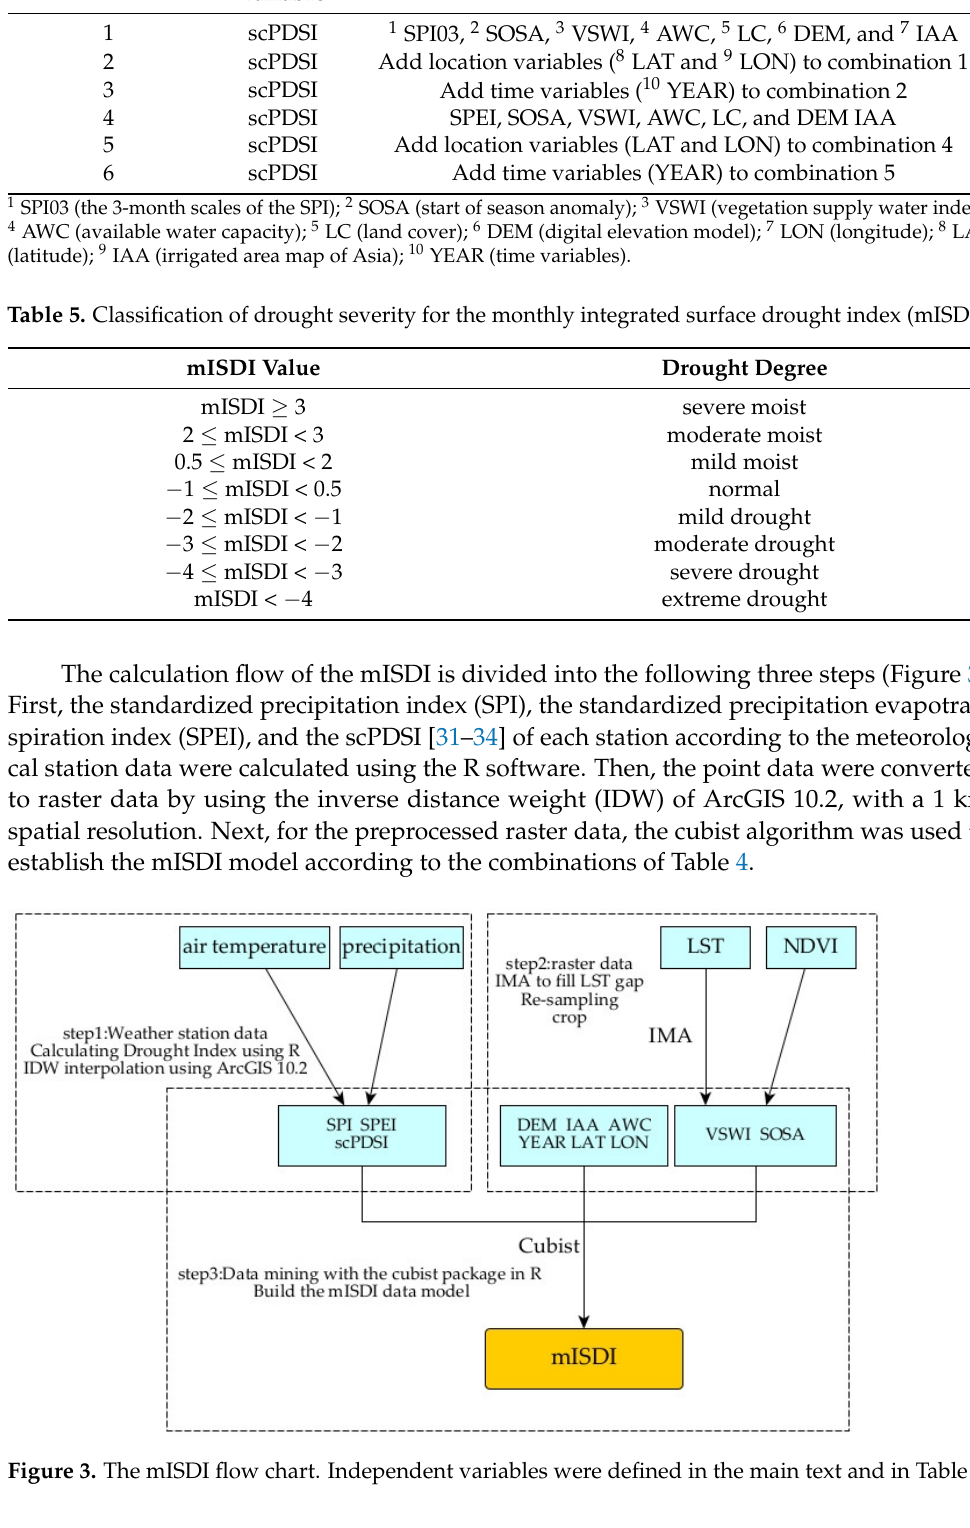
Table 4. Data combinations input into the model. Dependent Combinations Variable